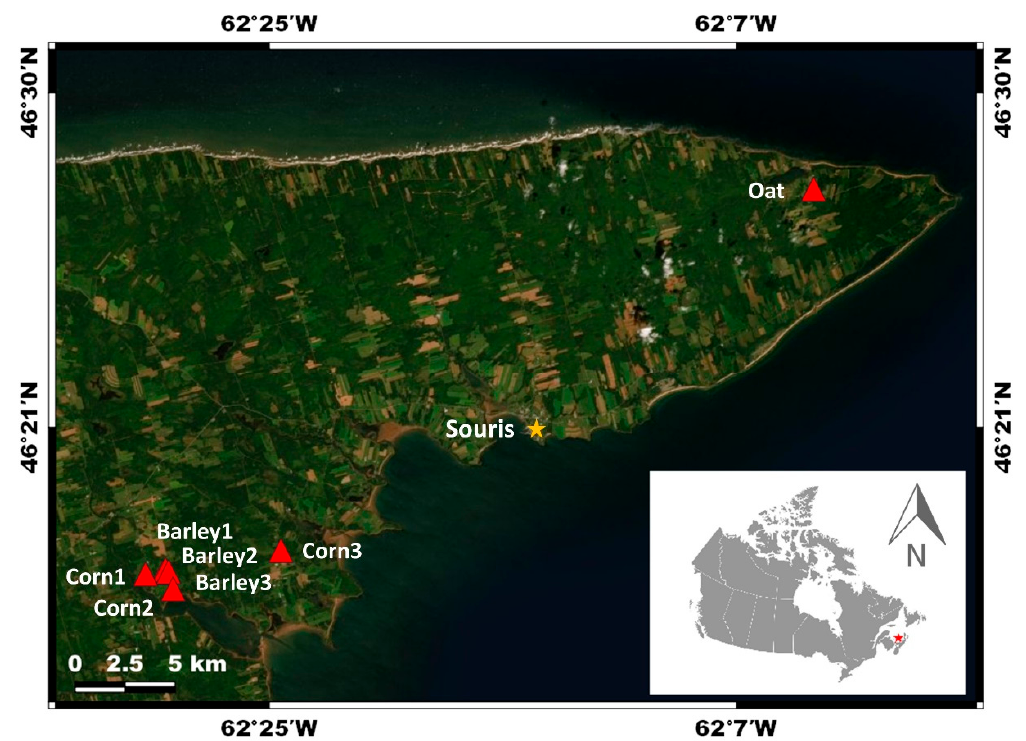
Figure 1. Location of the study sites in Prince Edward Island. ESRI Satellite (ArcGIS/World Imagery).